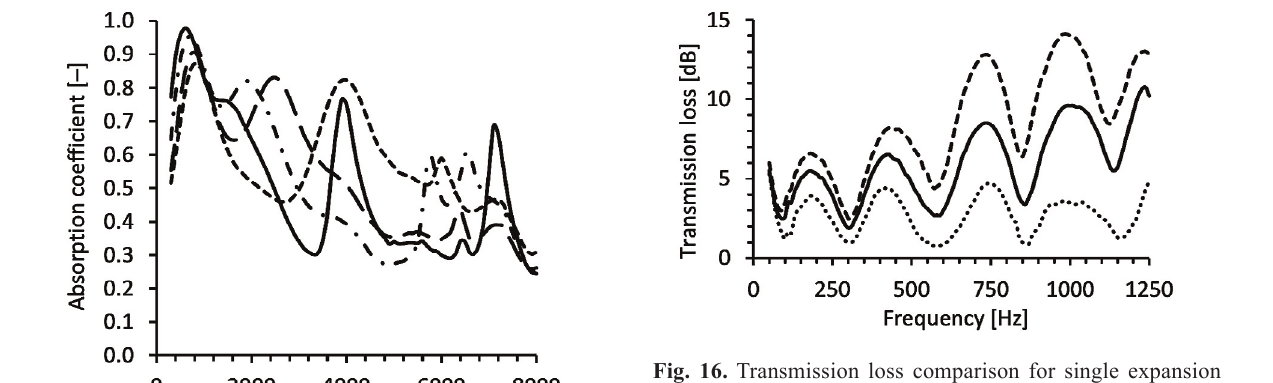
Fig. 16. Transmission loss comparison for single expansion chamber (dotted line) and with added microperforated inner tube (solid line). Double-layer concentrically placed inner tube (dashed line) with separation distance set to 10 mm shows even more potential.